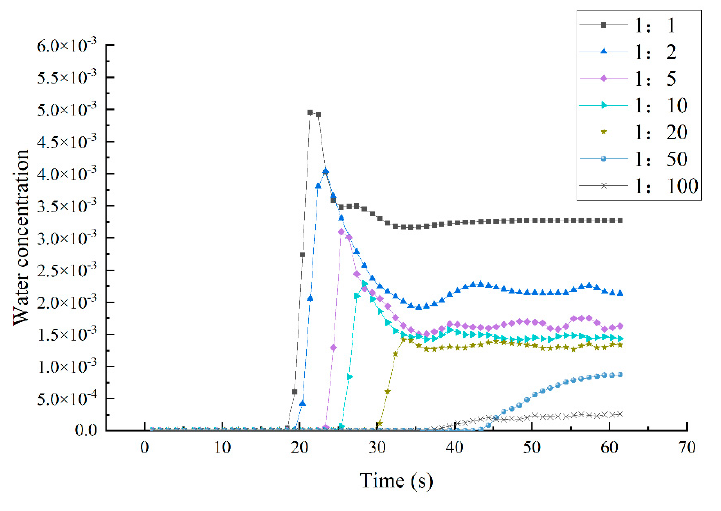
Figure 8. Water concentration changes with time under different similarity scales.